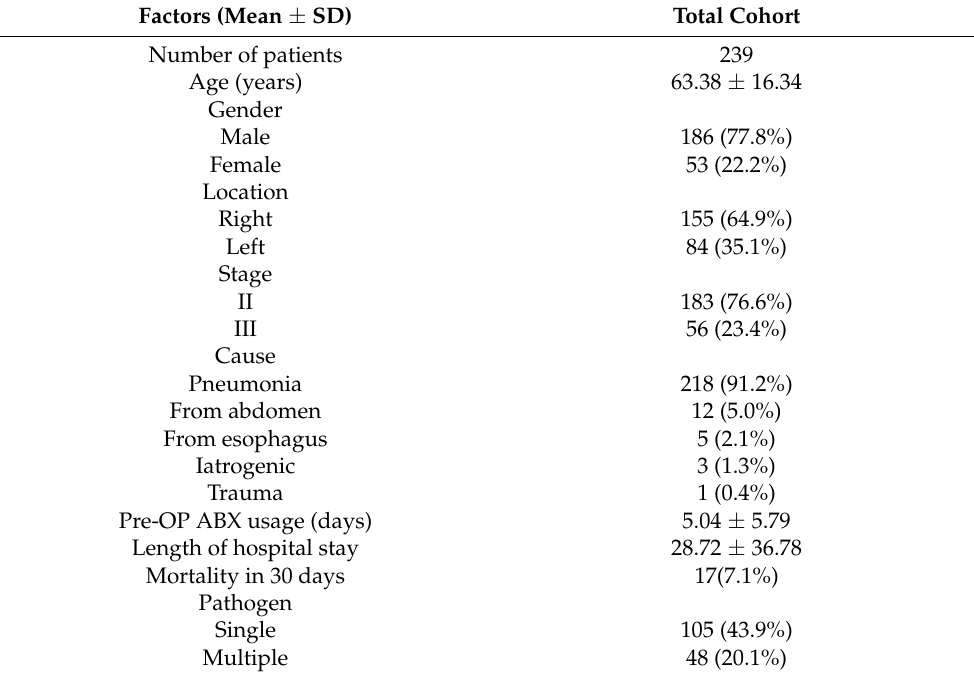
Table 1. Clinical demographic data of